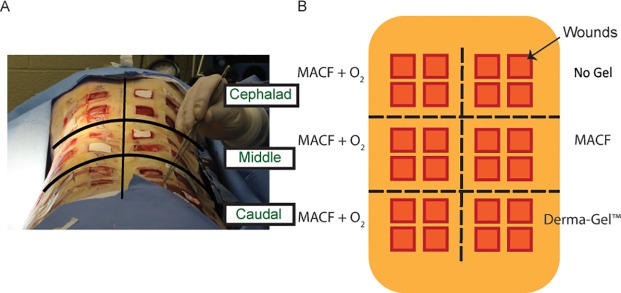
A) Wound arrangement and B) treatment assignment on the back of pigs.